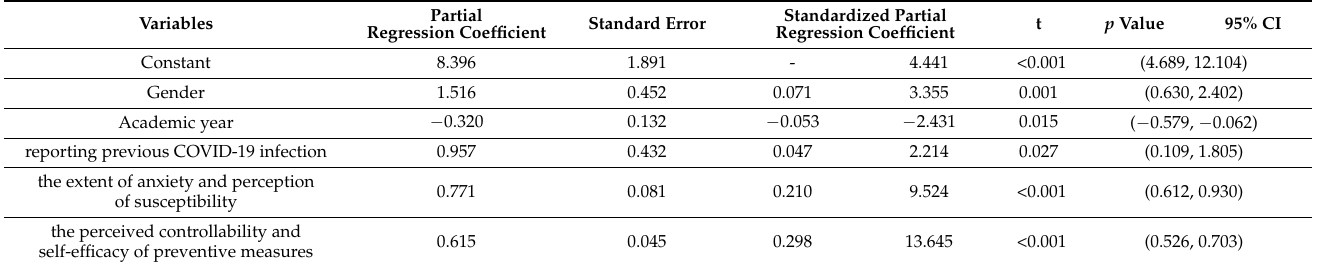
Table 4. Multivariate linear regression analysis on the protective behaviors following the